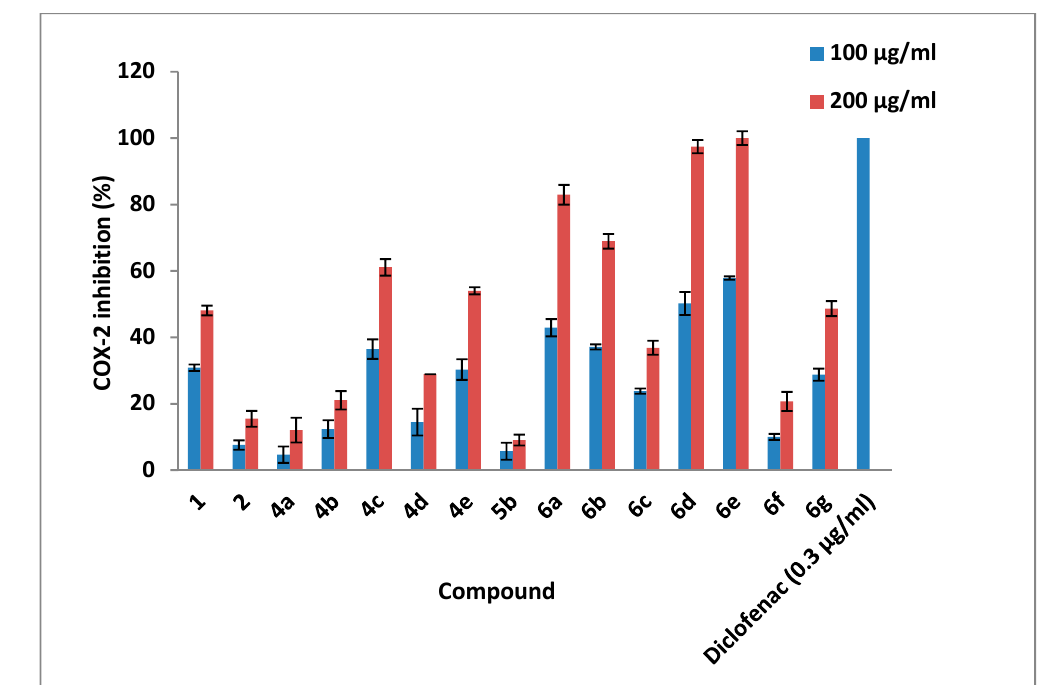
Figure 2. Evaluation of the COX-2 inhibitory properties of the synthesized quinoxalinone and quinazolinone derivatives by the determination of the mean inhibition efficiency at 100 and 200 µg/mL concentrations.